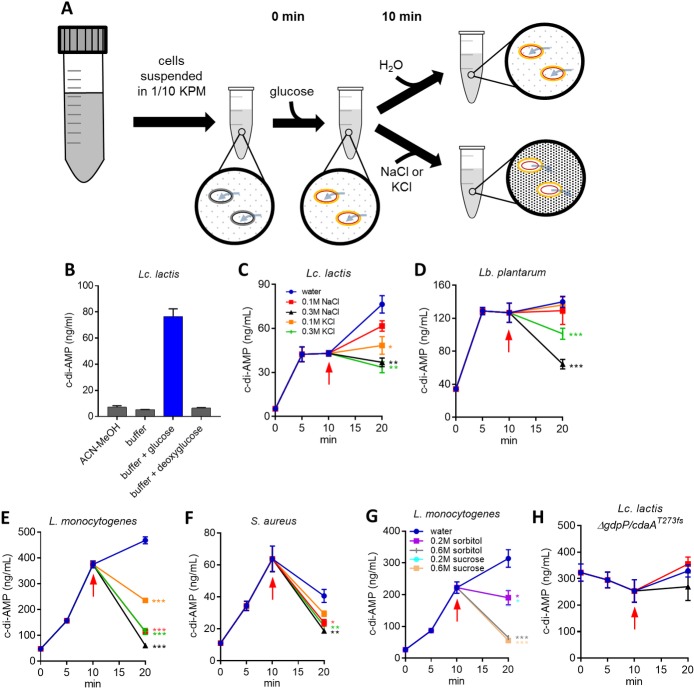
C-di-AMP levels in non-growing energised cells respond rapidly to environmental osmolarity changes.(A) Schematic diagram showing the steps in the non-growing cell suspension assay. Cells are suspended in a low osmolarity buffer causing water influx. Glucose is added to energise the cells at time 0 to provide ATP for c-di-AMP synthesis. After 10 mins, either water or NaCl/KCl is added causing further cellular hydration or cellular dehydration, respectively. (B) C-di-AMP levels in Lc. lactis WT suspended in different solvents/solutions: ACN-MeOH (acetonitrile:methanol) or buffer (1/10 KPM) with and without glucose and deoxyglucose. (C) C-di-AMP levels in Lc. lactis WT cells in 1/10 KPM buffer + glucose. After the 10 min (arrow), cells were treated with water, 0.1M NaCl, 0.3M NaCl, 0.1 KCl and 0.3M KCl and c-di-AMP levels were measured at 20 mins. The same experiment was carried out for cells of Lb. plantarum
(D), L. monocytogenes
(E), S. aureus
(F), and Lc. lactis ΔgdpP/cdaAT273fs
(H) with the key for treatments the same as that shown in (C). Non-ionic treatments (sucrose and sorbitol) were also performed using L. monocytogenes
(G). Mean ± SEM levels of c-di-AMP were measured from three independent cell suspensions. P < 0.001 (***), P < 0.01 (**) and P < 0.05 (*) indicate significant differences at the 20 minute time point relative to the water addition sample (one-way ANOVA followed by Student’s t test).